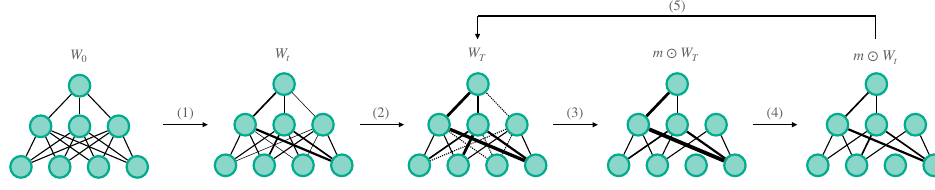
Figure 6. Illustration of the lottery ticket experiment, consisting of 5 steps, and providing the so-called winning (or matching) ticket.